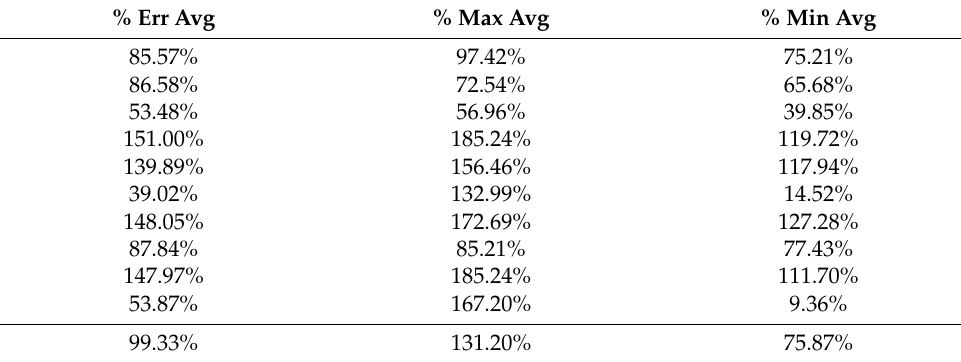
Table A42. Set 1, trials 21–30 data (all 0.5 PR values).